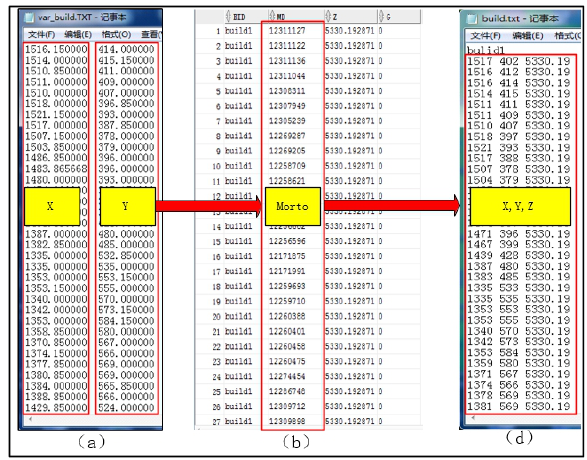
Figure 8. Schematic diagram of Data inspection